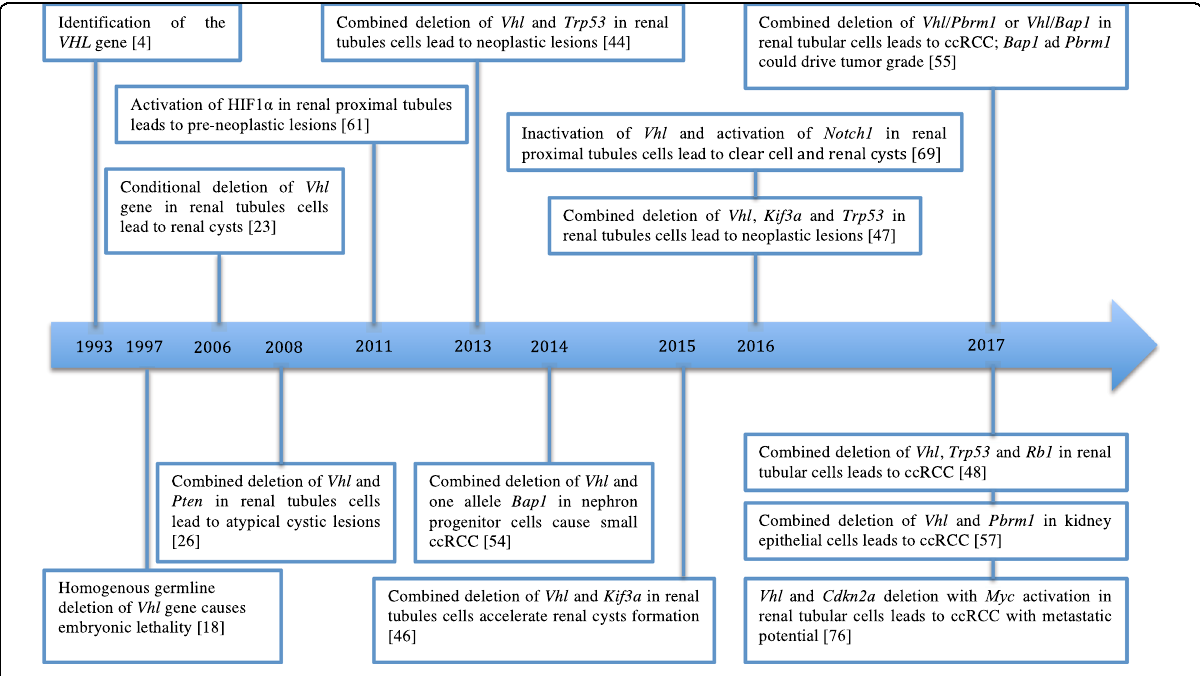
Fig. 1 Timeline. Key events in the method of generating GEM models of